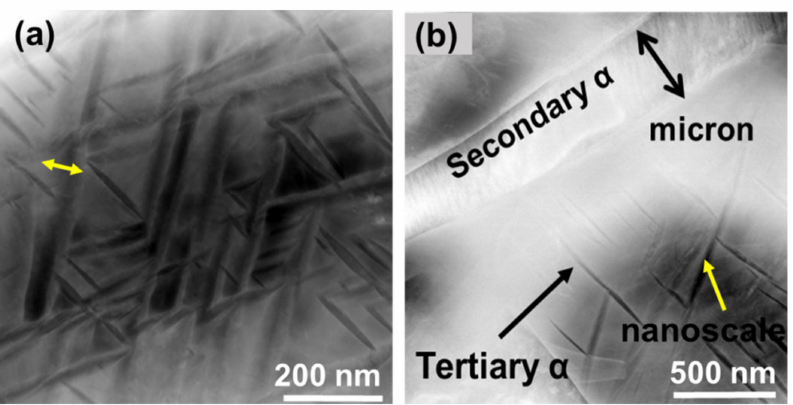
Figure 7. TEM (transmission electron microscopy) microstructures after heat treatment at 780 ◦ C/0.5 h + 650 ◦ C/4 h + 500 ◦ C/4 h: ( a ) microstructure of α phase, ( b ) formation of multi- scale